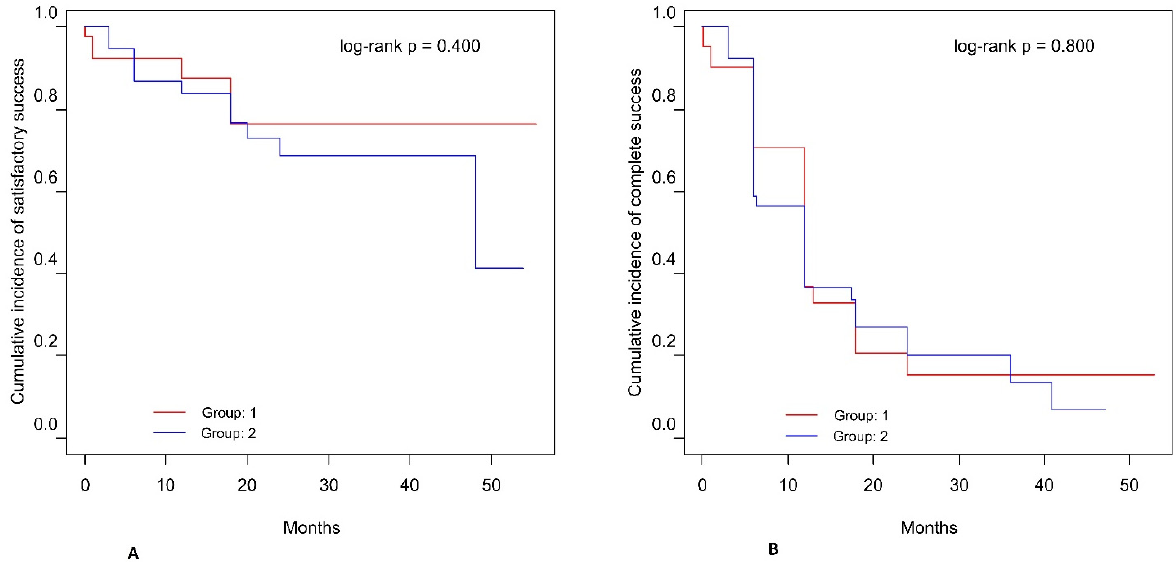
Figure 1. Kaplan-Meier cumulative incidence of qualified success and complete success. Qualified success was defined as a decrease of 20% in IOP, or IOP ≤ 18 mmHg with or without medication ( A ). Complete surgical success was defined as a decrease of 20% in IOP, or IOP ≤ 18 mmHg without medication ( B ).